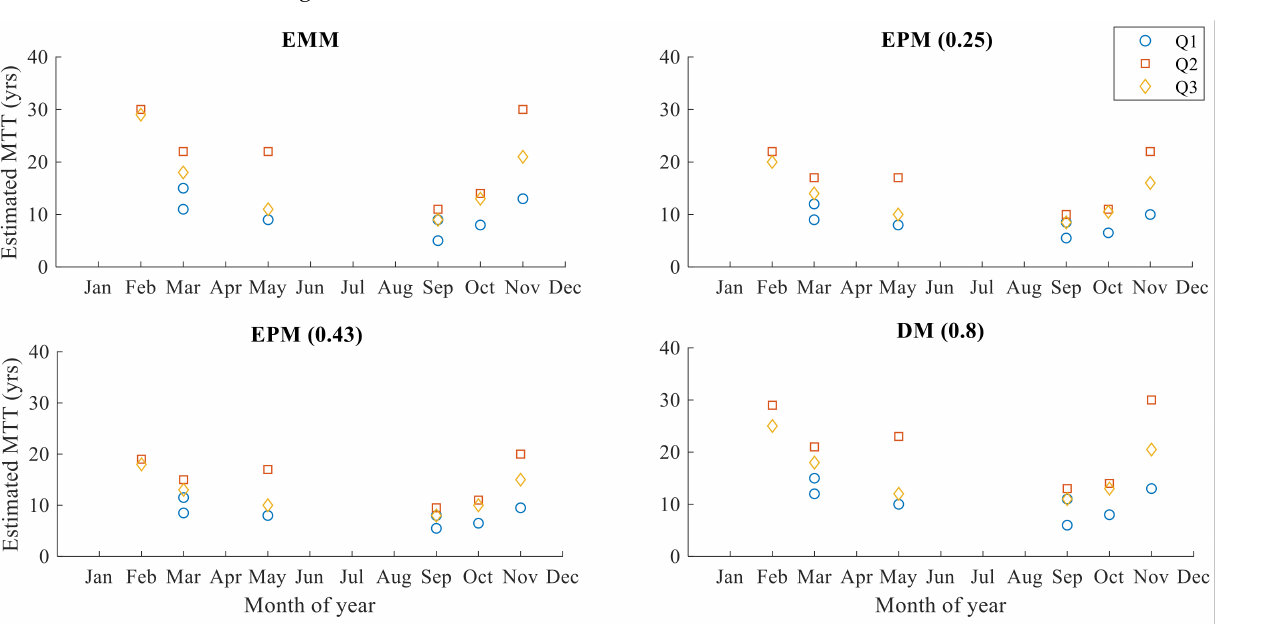
Figure 4. Mean transit times by month for each of the four models.